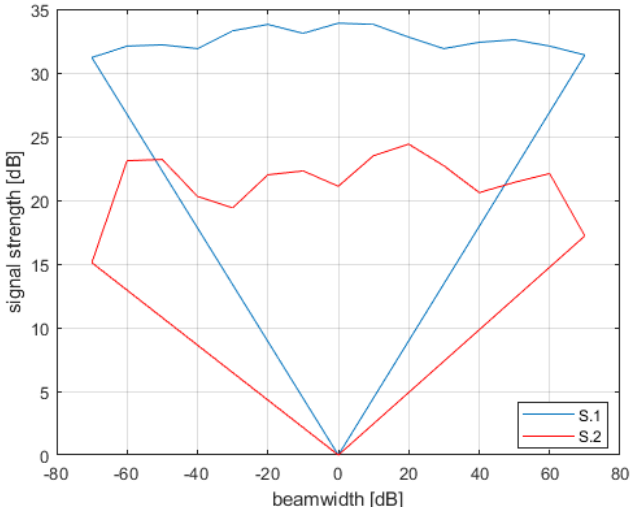
Figure 17. Comparison between the signal strength in S.1. (blue) and S.2. (red) setup with the PGS in